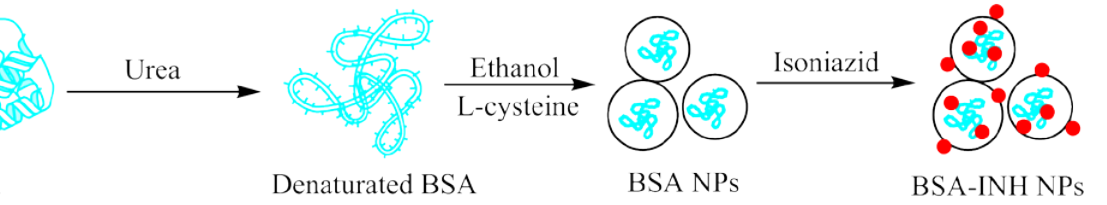
Figure 1. Scheme for obtaining BSA-INH NPs.